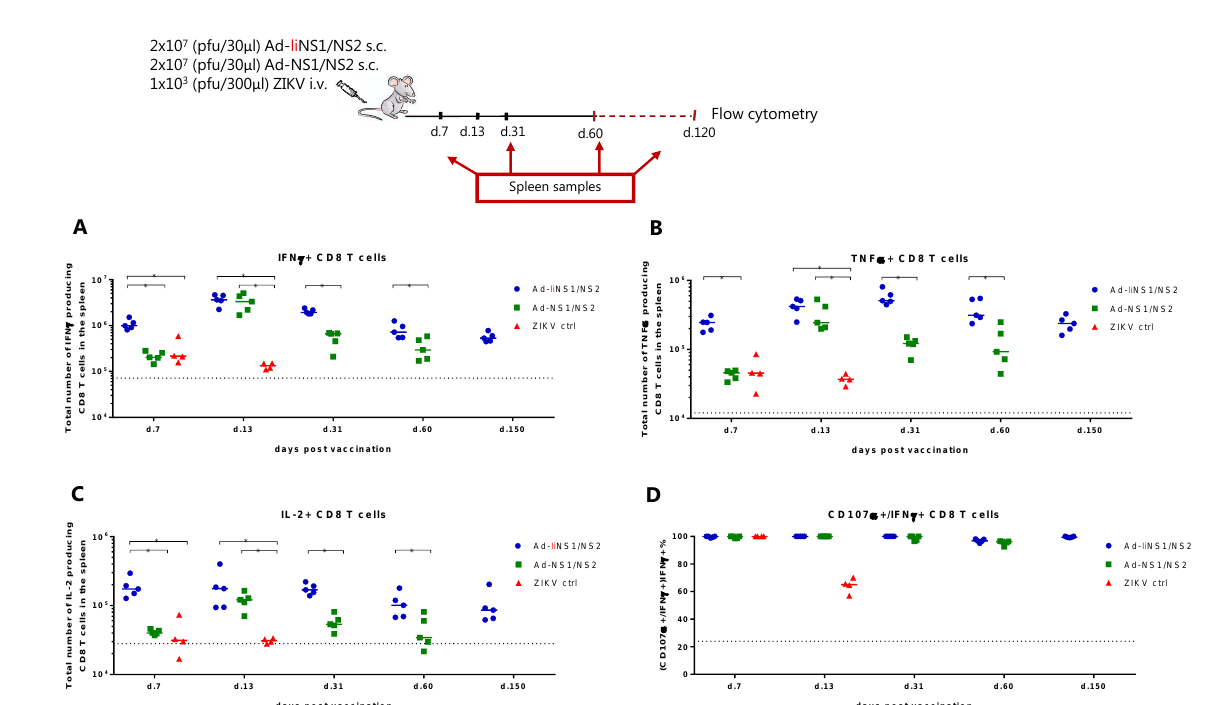
Figure 3. CD8 T cell response induced by the Ad-liNS1/NS2 and Ad-NS1/NS2 vaccines. WT C57BL/6 mice were vaccinated s.c. with 2 × 10 7 pfu of either vaccine (Ad-liNS1/NS2 and Ad-NS1/NS2). ZIKV-immune and naive mice were included for control. On days 7, 13, 31, 60, and 150 post vaccination, spleens were harvested and CD8 T cells were examined by ICS (for details, see M & M) for the total numbers of IFN γ -producing CD8 T cells ( A ), total numbers of TNF α -producing CD8 T cells ( B ), and total numbers of IL-2-producing CD8 T cells ( C ) as well as the percentage of IFN γ -producing CD8 T cells co-producing CD107 α ( D ) following ex vivo peptide stimulation with NS2B 1478-1486 . Each dot represents an individual animal. The bars represent the group medians and the stippled line background. * p < 0.05. For representative flow plots, see Supplementary Figures S1 and